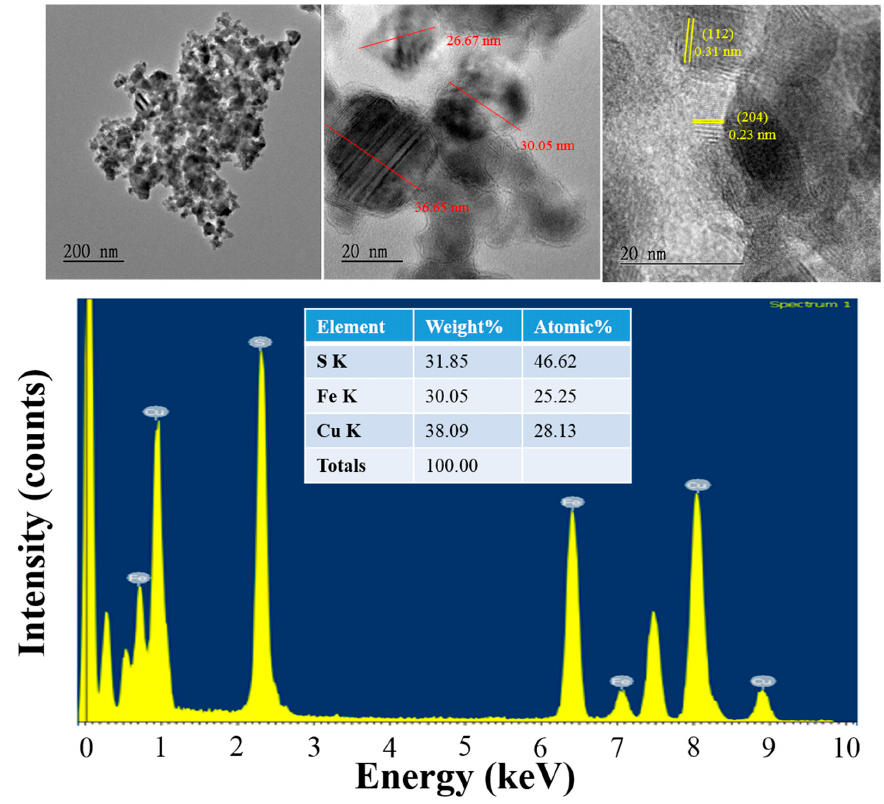
Catalysts 2022 , 11 , x FOR PEER REVIEW Figure 2. TEM images and EDS spectra of H-CuFeS 2 samples. Figure 2. TEM images and EDS spectra of H-CuFeS 2 samples.